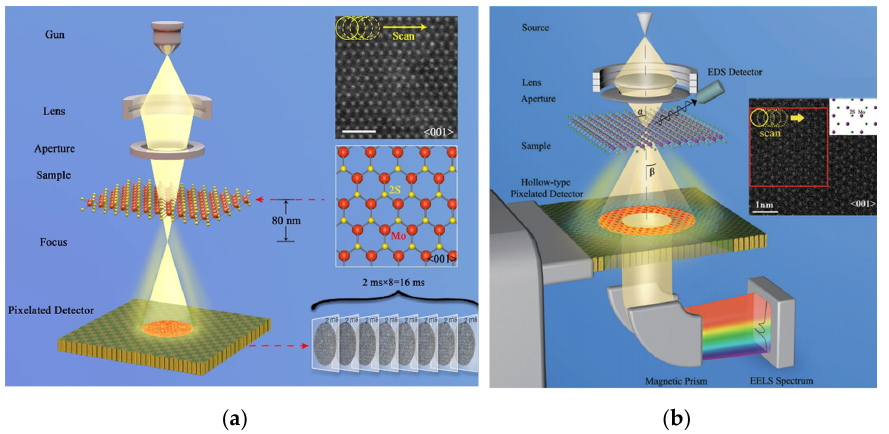
Figure 6. ( a ) Schematic diagram of the optical path of the 4D-STEM. Reprinted/adapted with permission from Ref. [55]. Copyright 2019, Springer Nature. ( b ) Based on the STEM mode, the ring-shaped electron detector is replaced by an arrayed detector, and the entire diffraction pattern is recorded at each scanning position Reprinted/adapted with permission from Ref. [56]. Copyright 2018, American Physical Society.